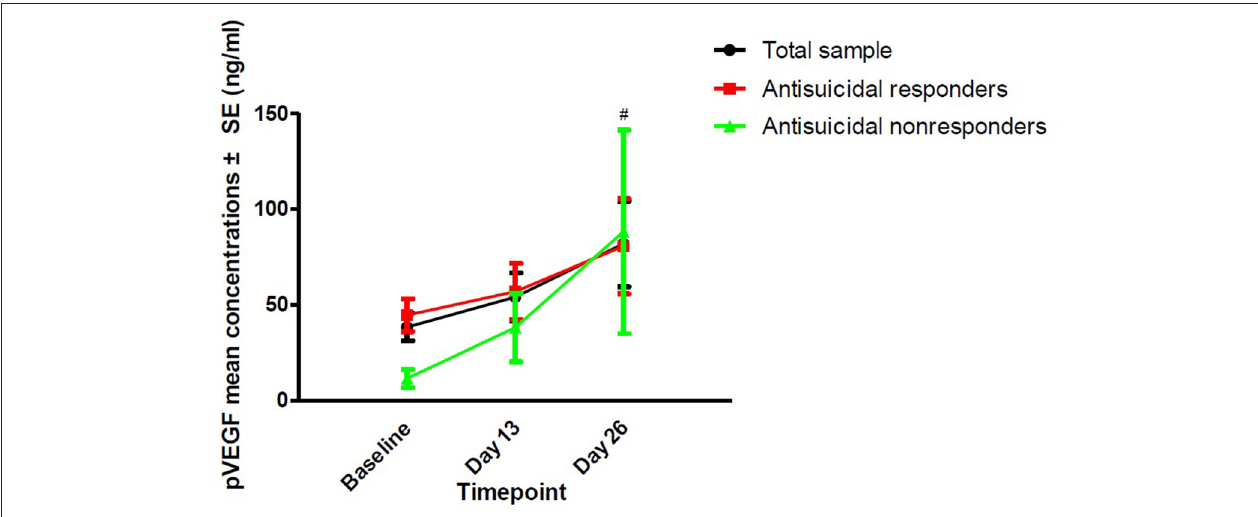
FIGURE 2 | The change in pVEGF concentrations in depressed patients with suicidal ideation at the indicated times. # No significant difference at the indicated times was found when compared to baseline ( P > 0.05). No significant difference at the indicated times was found between antisuicidal responders and non-responders ( P > 0.05). pVEGF, plasma vascular endothelial growth factor.